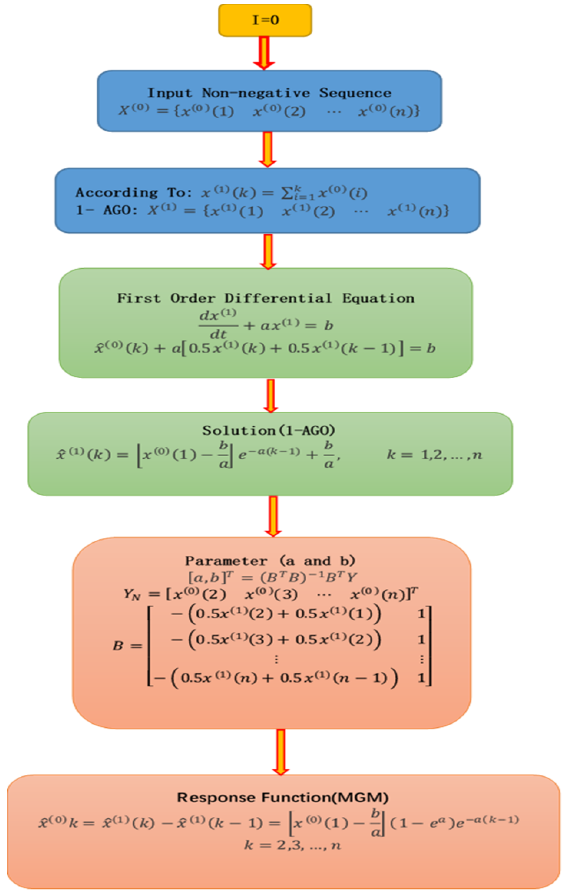
Figure 1. Method flow chart of MGM (1,1) model.